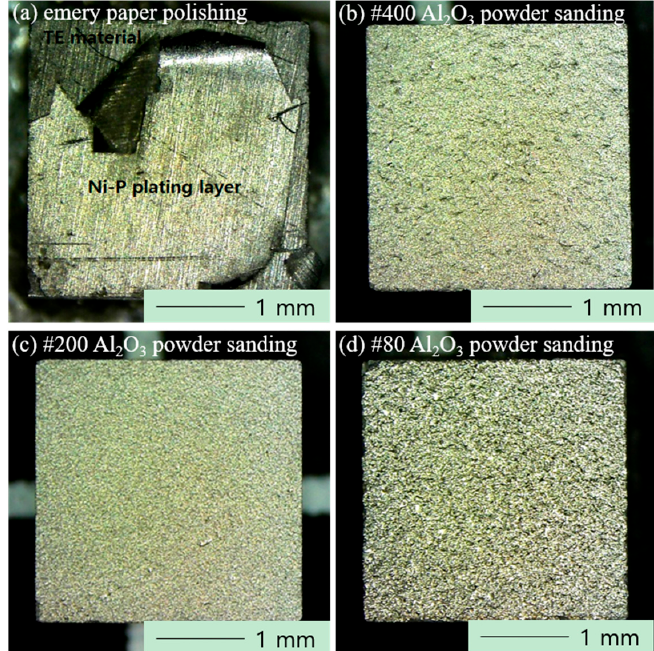
Figure 1. Digital microscope images on the surfaces of the thermoelectric element blocks after electroless Ni plating. The images of the surfaces ( a ) polished by emery paper; ( b ) by #400 Al 2 O 3 powder sanding; ( c ) by #200 Al 2 O 3 powder sanding; and ( d ) by the #80 Al 2 O 3 powder sanding.